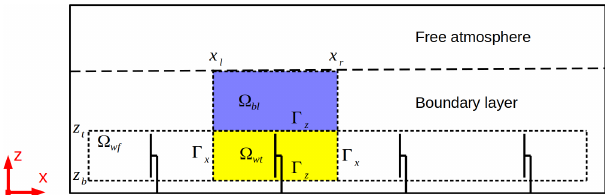
Figure 11. Sketch of wind turbine control volumes (cid:127) wt , BL con- trol volumes (cid:127) bl and the wind farm control volume (cid:127) wf . In the x direction the control volumes are bounded by the surfaces (cid:48) x at x = x l and x = x r . In the vertical direction, the control volumes are bounded by (cid:48) z at z = z b and z = z t . In the y direction the control volumes are bounded by the cyclic domain boundaries. The control volumes are centered on the respective turbine